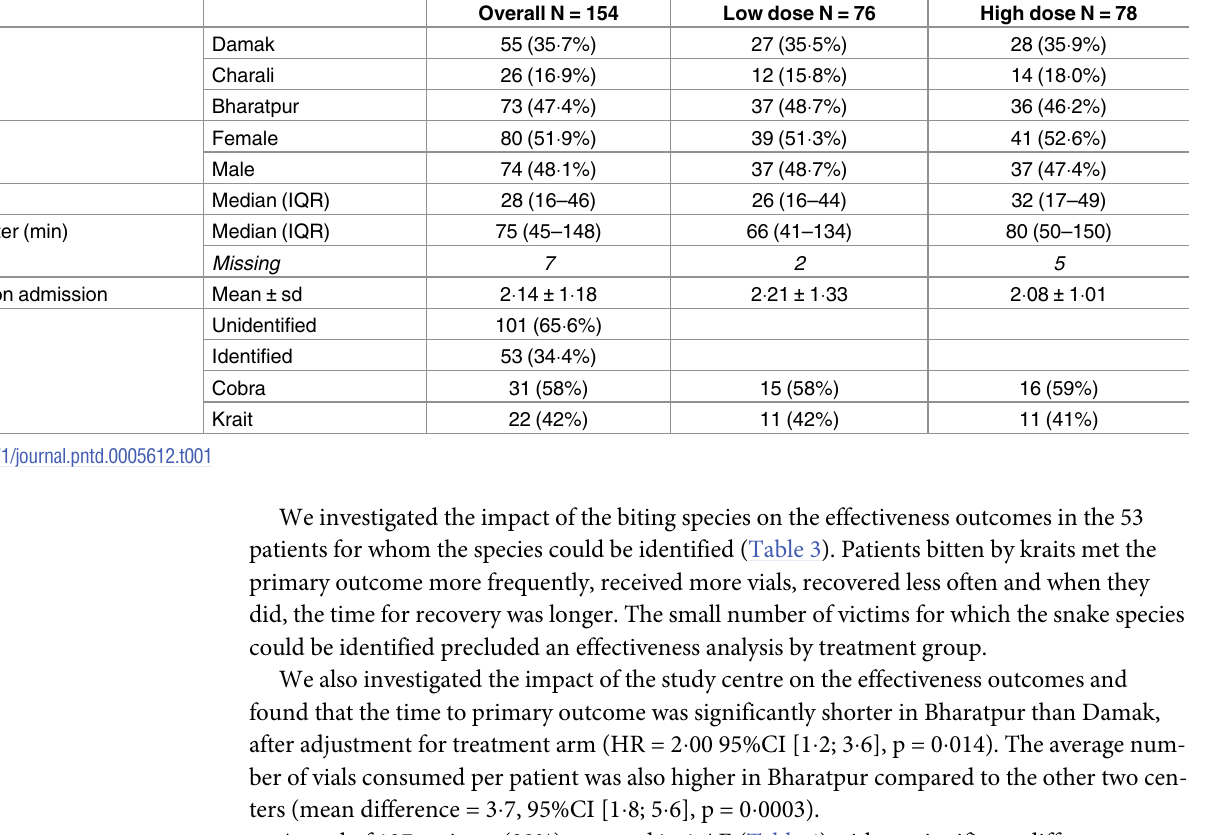
Table 1. Baseline demographic and epidemiological characteristics of trial participants. Figures are numbersof participants(percentage)unless stated otherwise.